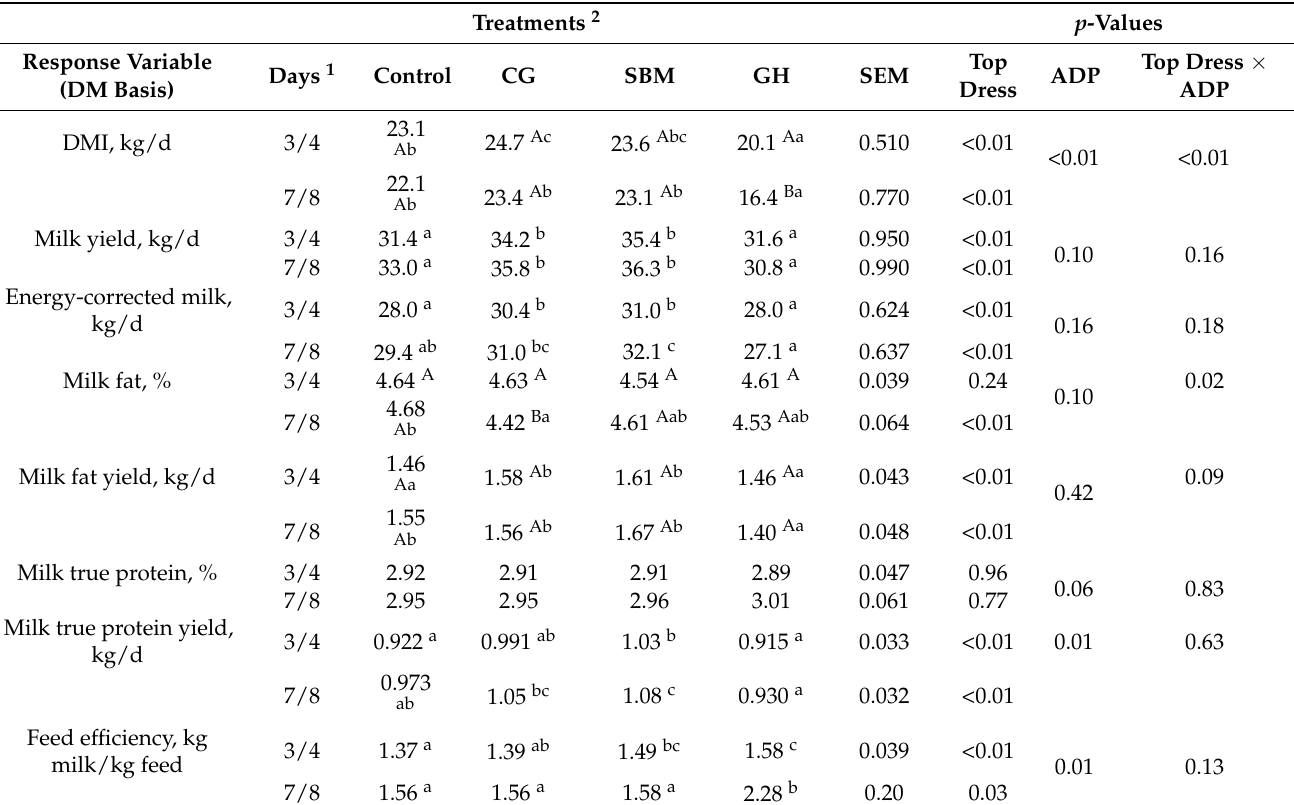
Table 5. Mean production performance responses of cows consuming experimental treatment diets of TMR with and without the addition of CG, SBM, or